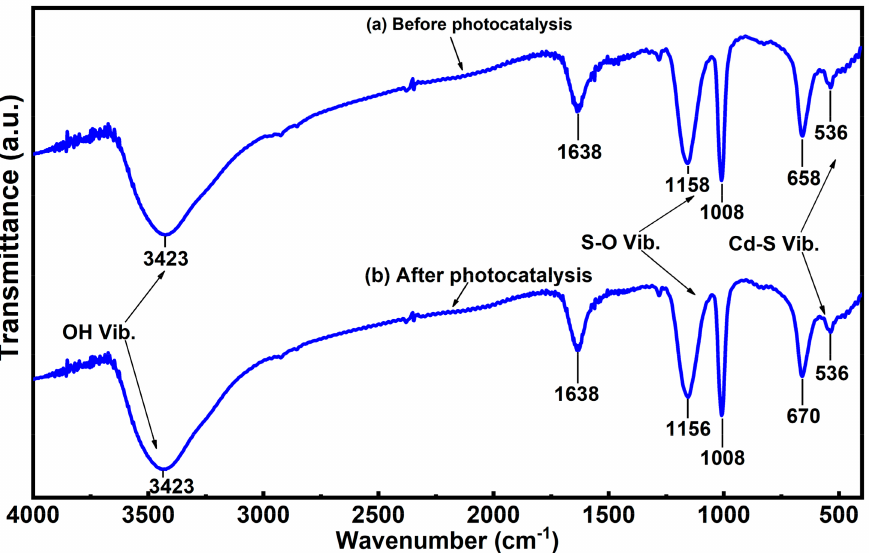
Figure 5. The FT-IR study of CdS NPs before and after photocatalysis ([Cd] = 80 mg L − 1 ; [S 2 O 32 − ] = 0.01 mol L − 1 ; 298 K; uncontrolled